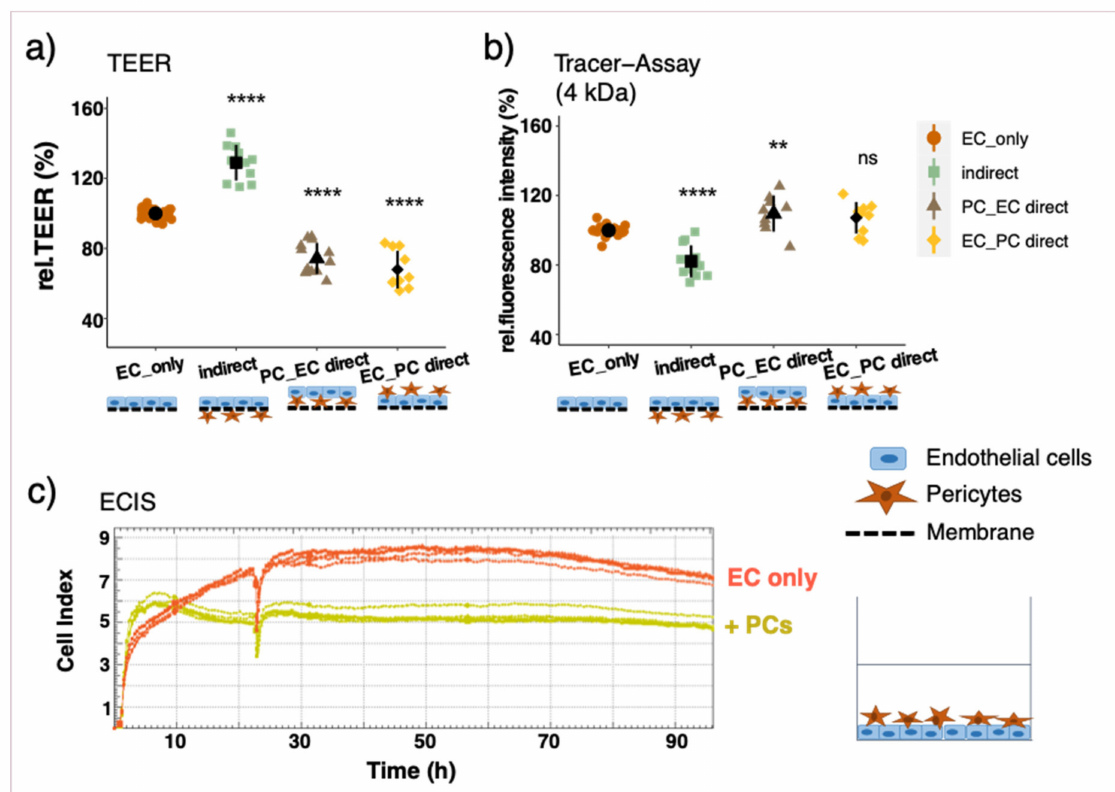
Figure 3. Measurements of endothelial barrier function with and without pericytes (PCs) in different constellations. Endothelial cells (ECs) were cultured on transwell inserts alone (EC_only), with PCs on the opposite side of the insert (indirect) or on the same side (PC_EC direct: PCs seeded first; and EC_PC direct: ECs seeded first). Cells were cultured for 7 days before barrier function was assessed. Relative trans-endothelial electric resistance (TEER) measurements with a CellZcope instrument ( a ). Relative fluorescence intensity measured by macromolecular tracer assay with FITC-dextran 4 kDa ( b ); results for 40 kDa FITC-dextran are comparable (data not shown). Representative ECIS measurements in real-time with the xCELLigence System: ECs were seeded into eplates 3 h before PCs were added on top ( c ). Experiments have been performed at least three times in triplicates and data represent mean ± sd. ** p < 0.01, **** p < 0.0001, compared to